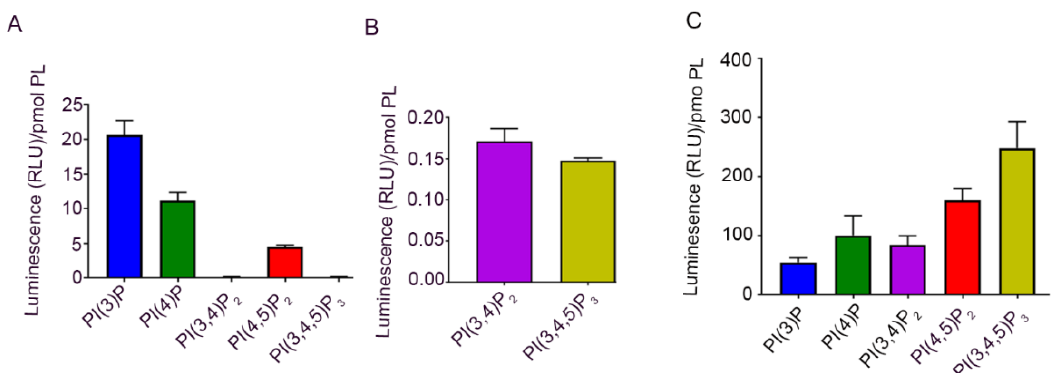
Figure 3. Identification and determination of the levels of PIs in the cornea and retinal pigment epithelium (RPE). The PI(3)P, PI(4)P, PI(3,4)P 2 , PI(4,5)P 2 , and PI(3,4,5)P 3 levels were measured from the cornea ( A ). As the levels of PI(3,4)P 2 and PI(3,4,5)P3 were low in the cornea, we plotted a graph on a di ff erent scale to show their presence in the cornea ( B ). The PI(3)P, PI(4)P, PI(3,4)P 2 , PI(4,5)P 2 , and PI(3,4,5)P 3 levels were measured from the RPE ( C ). Data are mean ± SEM ( n = 3).